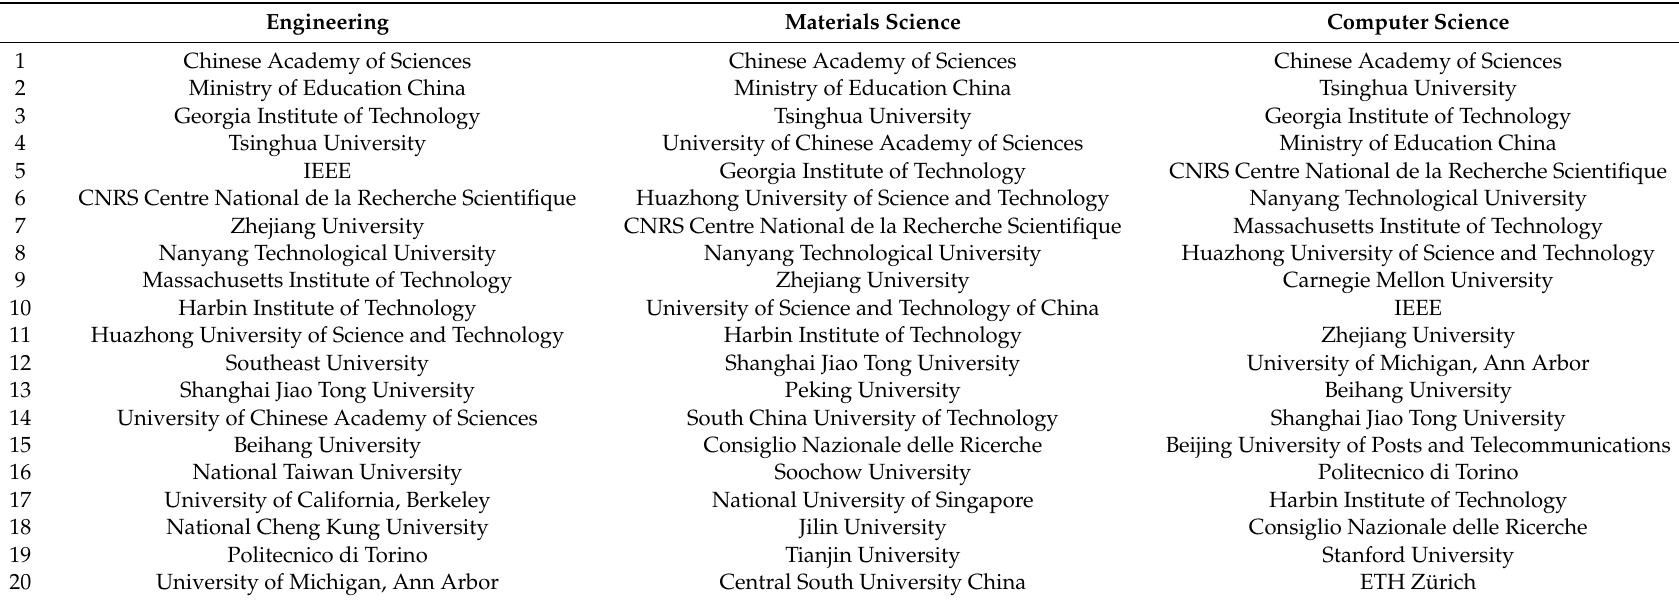
Table 4. Worldwide publications by a ffi liation / university on low cost for the top three